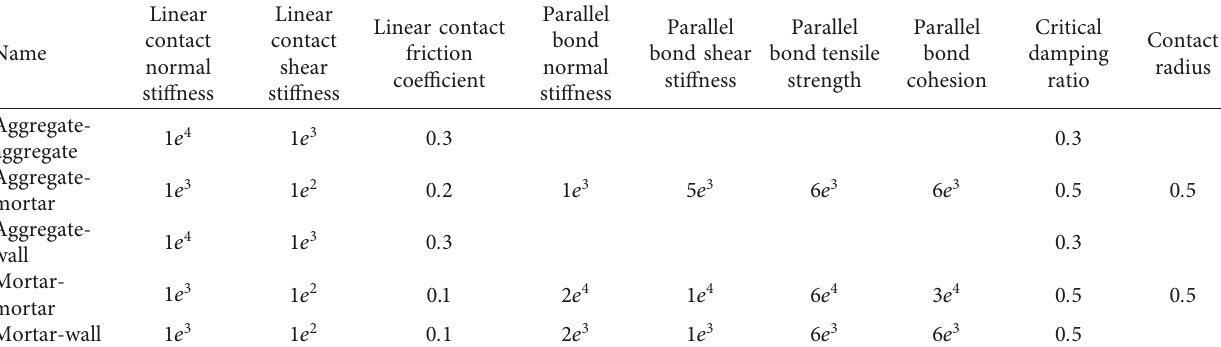
Table 6: Contact parameter table.